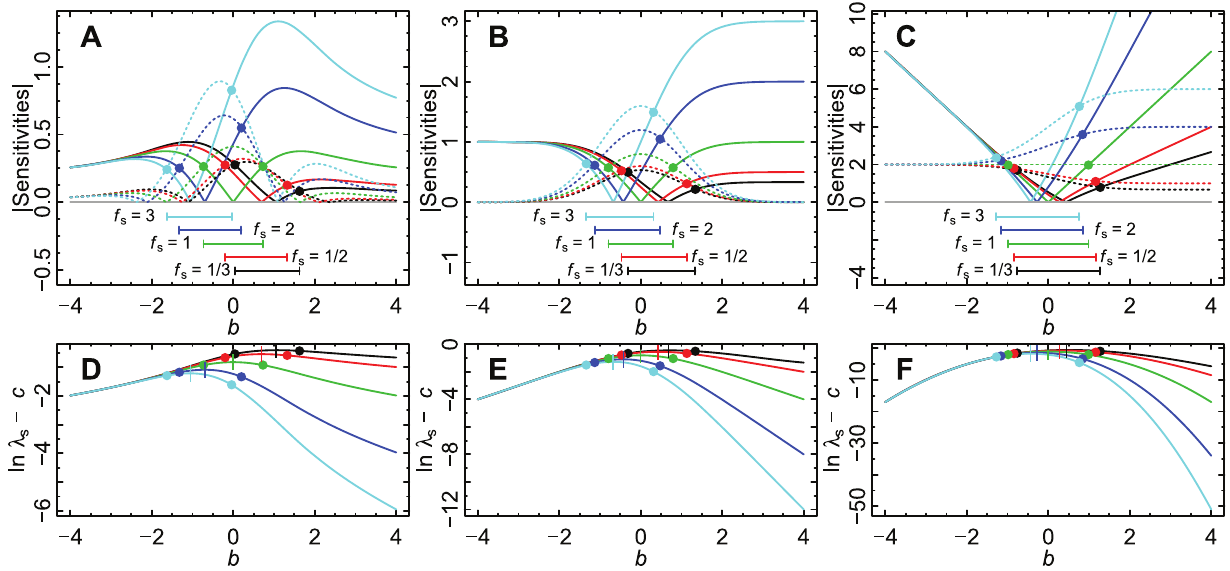
Figure 3. Comparison of the magnitudes of sensitivities. The relative sizes of j L ln l s = L m j and j L ln l s = L s j indicate which has a stronger effect on the long-term stochastic growth rate, changes in the mean of the environment (if j L ln l s = L m j w j L ln l s = L s j ) or changes in the standard deviation of the environment (if j L ln l s = L m j v j L ln l s = L s j ); relative sizes of these quantities are depicted here. (A–C) Absolute values of the sensitivities of Figure 2; solid lines are j L ln l s = L m j (taking L ln l s = L m from Figure 2A–C) and dotted lines are j L ln l s = L s j (taking L ln l s = L s from Figure 2D–F). Dots indicate points at which solid and dotted lines of the same color cross, and hence where changes in mean environment become more important than changes in the standard deviation of the environment, or vice versa. Dots line up with the endpoints of the ranges below each plot and indicate the b for which j L ln l s = L s j w j L ln l s = L m j ( b * ; 2 ). The message here is that when the mean environment is close to the peak of the response function, changes in the standard deviation of the environment have a bigger effect on the long-term stochastic growth rate than changes in the mean of the environment. (D–F) The difference ln l s { c , which shows how ln l s depends on b . Dots are placed to line up with those in panels A–C, to show that b for which j L ln l s = L s j w j L ln l s = L m j correspond to b for which ln l s is large. Vertical lines indicate maxima. The maxima occur at values of b for which the sensitivity to changes in s is greater than the sensitivity to changes in m . Here a 2 ~{ 1 , and a ~ 1 = 2 (A, D), a ~ 1 (B, E), or a ~ 2 (C, F). Conclusions are identical to those displayed here for other values of a 2 because changing a 2 only rescales the vertical axes of all panels (Sections S3 and S4 in